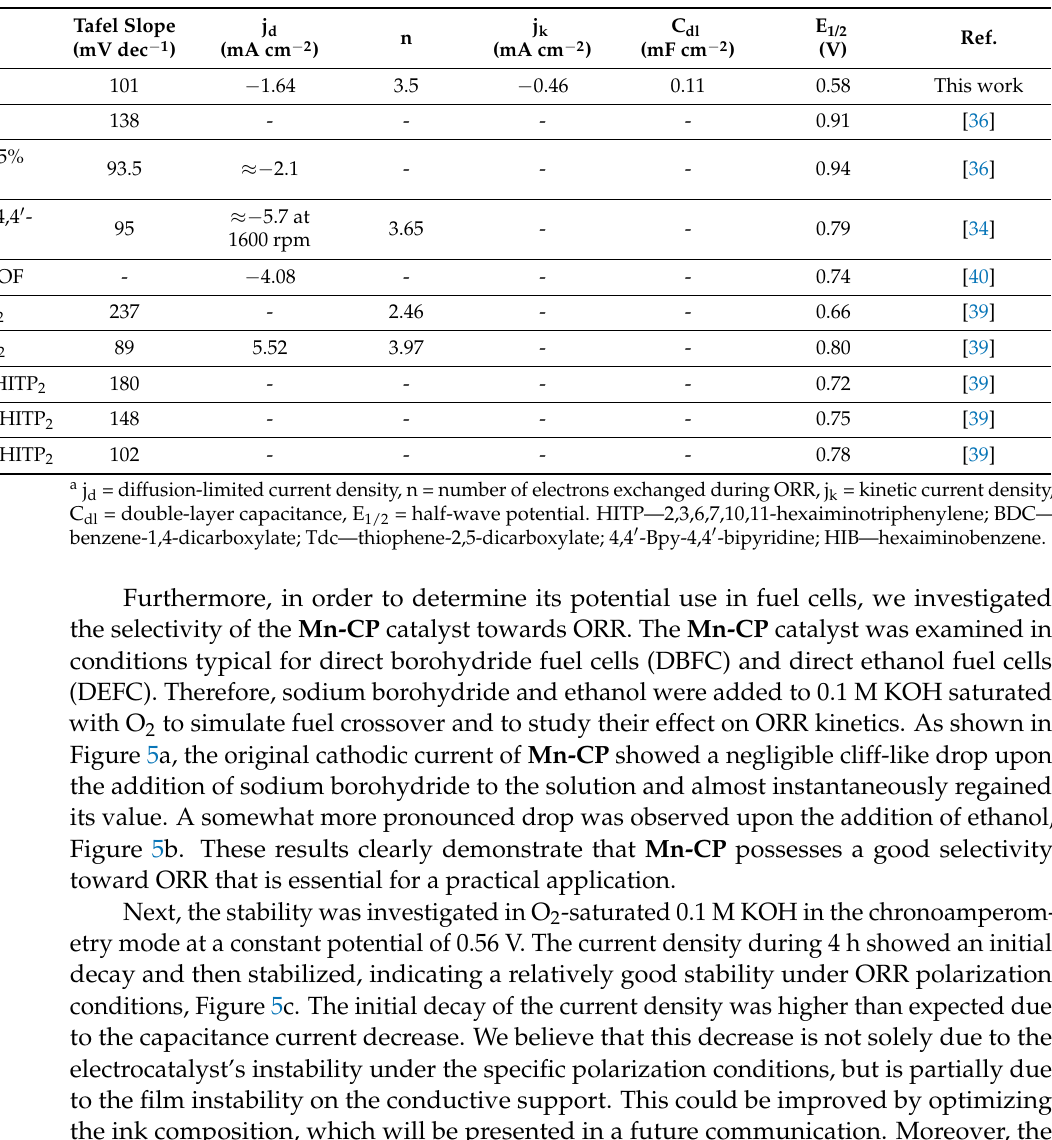
Table 1. Comparison of key parameters of ORR at Mn-CP in 0.1 M KOH with literature data a